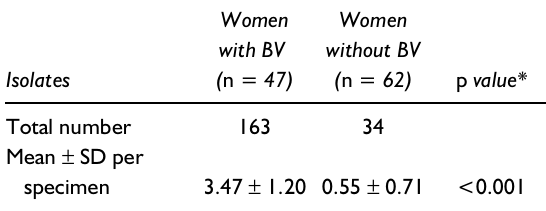
Table 2 Number of isolates in vaginal samples of 109 women with and without bacterial vaginosis